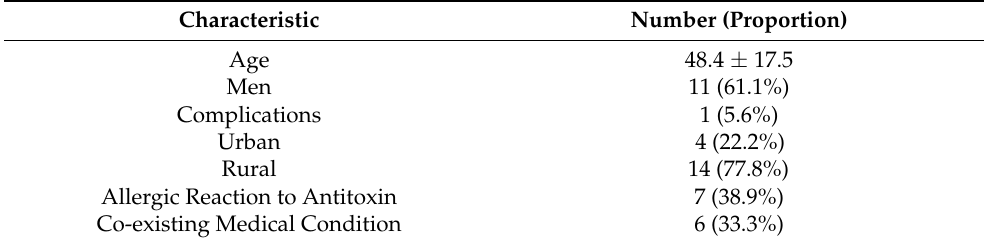
Table 2. Demographic characteristics of patients admitted with